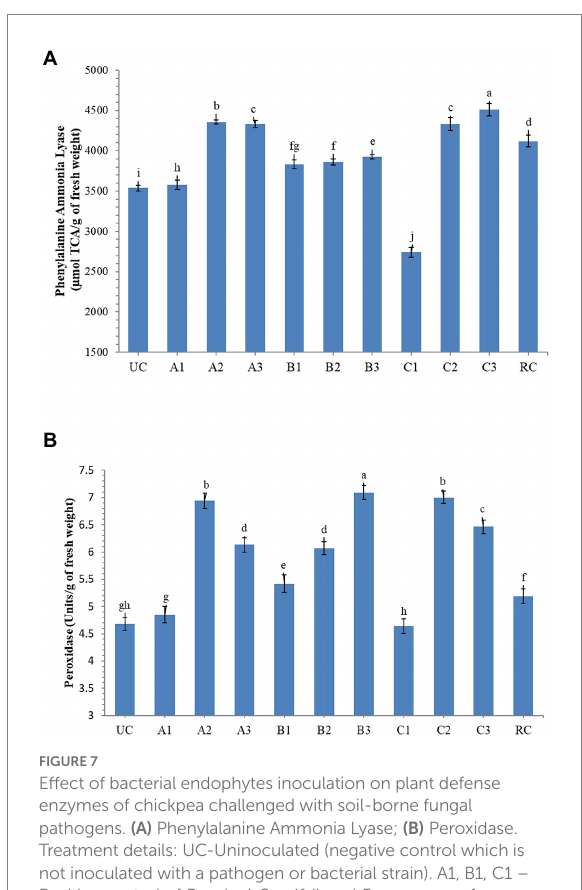
FIGURE 7 Effect of bacterial endophytes inoculation on plant defense enzymes of chickpea challenged with soil-borne fungal pathogens. (A) Phenylalanine Ammonia Lyase; (B) Peroxidase. Treatment details: UC-Uninoculated (negative control which is not inoculated with a pathogen or bacterial strain). A1, B1, C1 – Positive control of R. solani , S. rolfsii, and F. oxysporum f. sp. ciceri , respectively in which only pathogen inoculated. A2, B2, C2 – Respective pathogen + B. subtilis strain TRO4 inoculated. A3, B3, C3 – Respective pathogen + B. subtilis strain